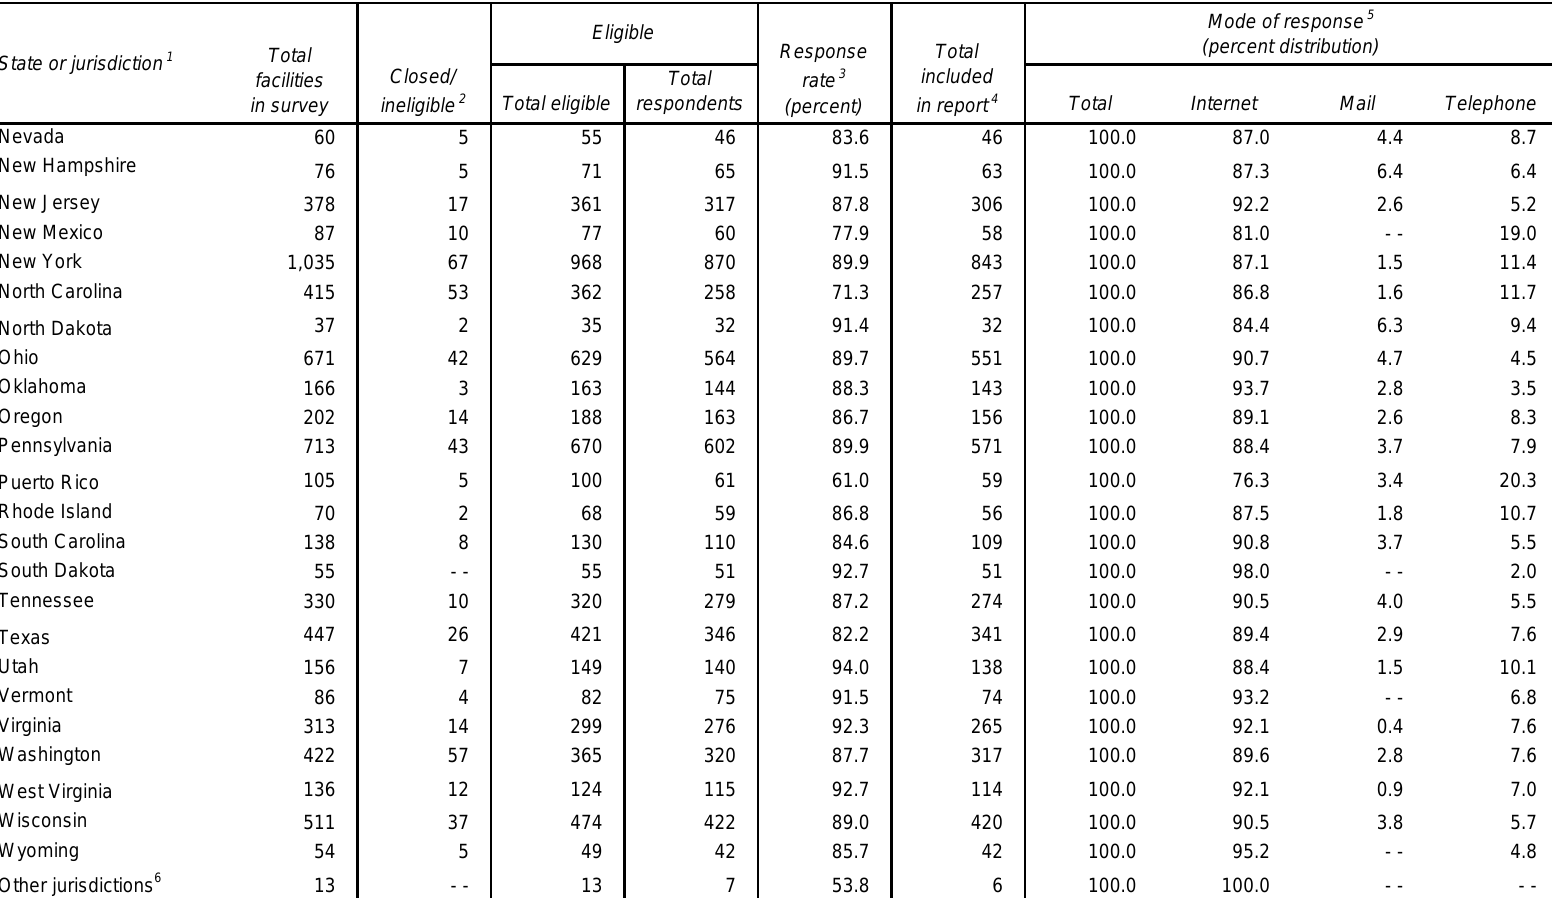
Table C2. N-MHSS facilities, by status, response rate, mode of response, and state or jurisdiction: 2017